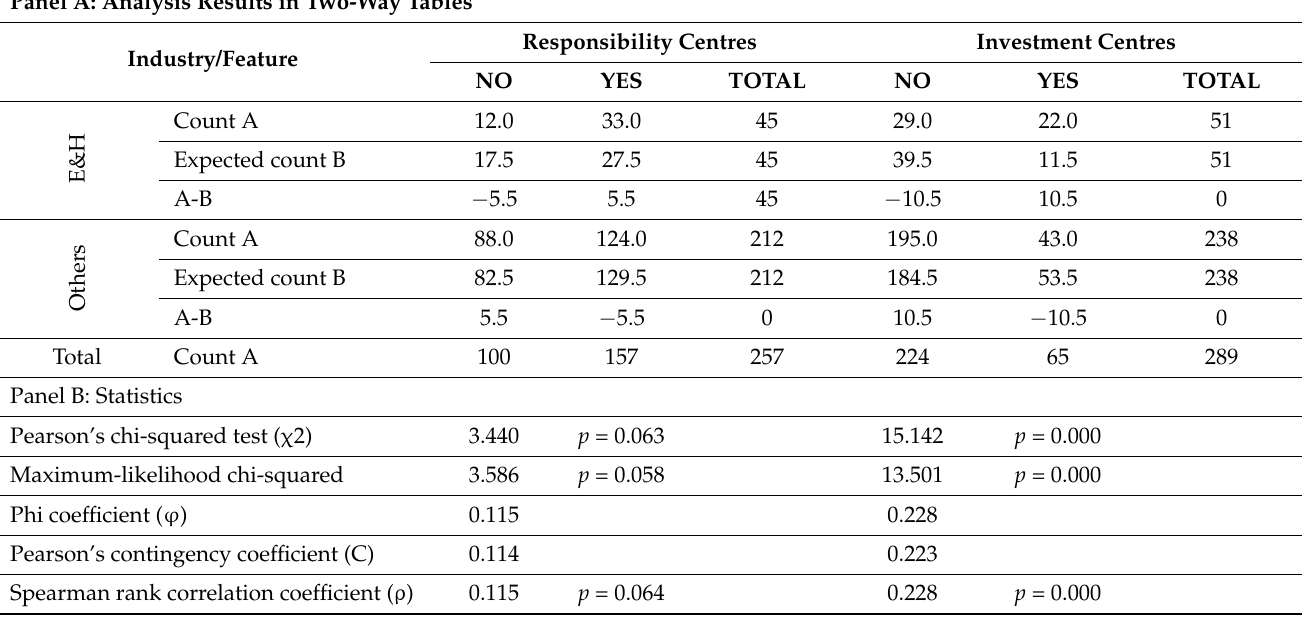
Table 4. Responsibility centres in the audited